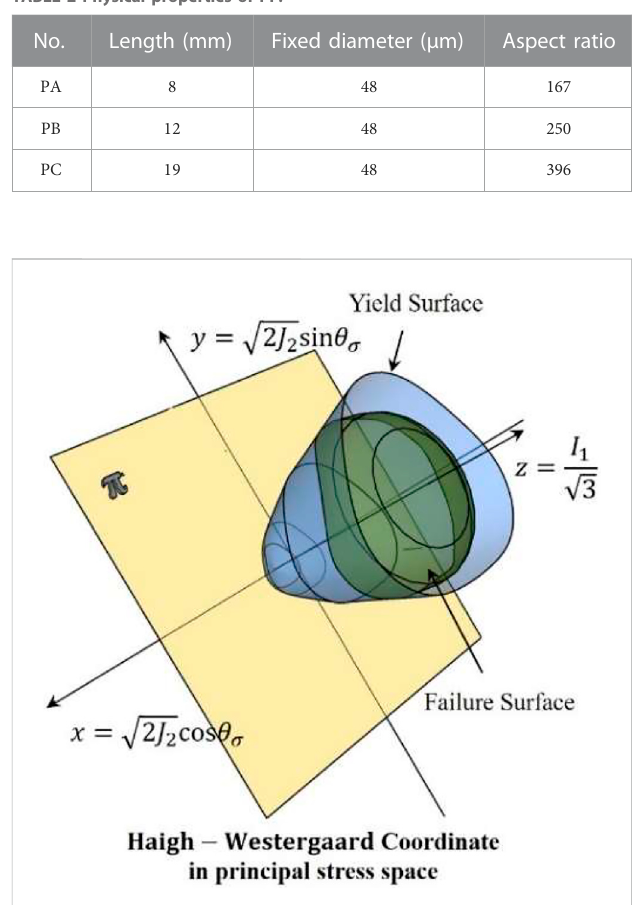
TABLE 2 Physical properties of